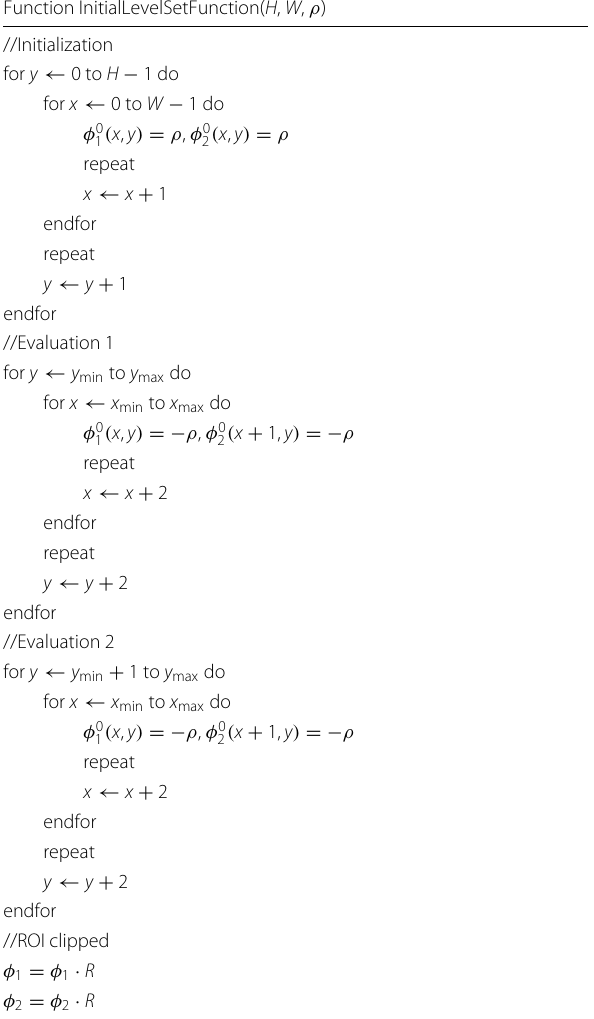
( x , y ) , φ 0 ( x , y 1 2